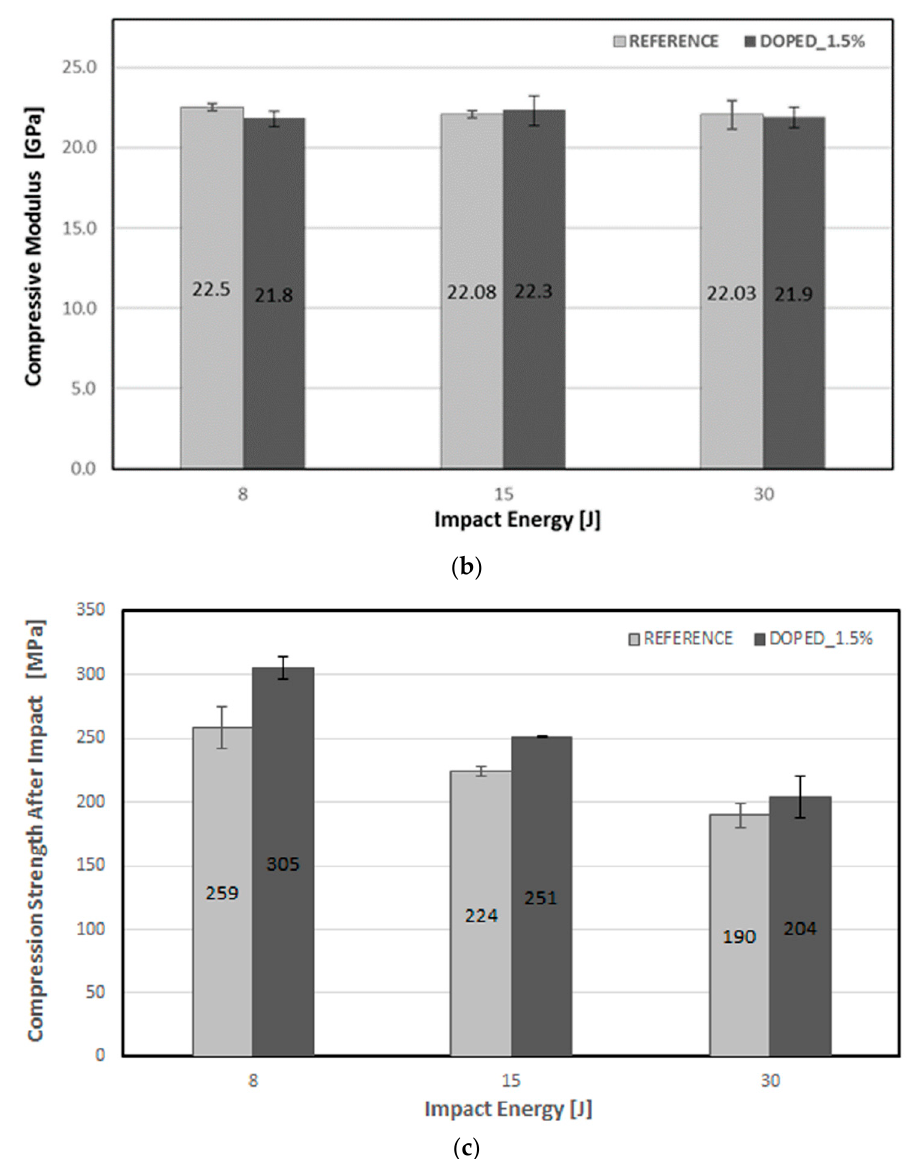
Figure 7. ( a ) Typical compressive stress versus compressive strain (%) curves resulted from CAI test for three energy impact levels (8, 15, 30 J) both for reference and nano ‐ doped CFRPs with 1.5 wt.% MWCNTs concentration, ( b ) Maximum compressive residual strength versus impact energy of the reference and modified CFRPs and ( c ) Compressive modulus vs impact energy of the reference and modified CFRPs.